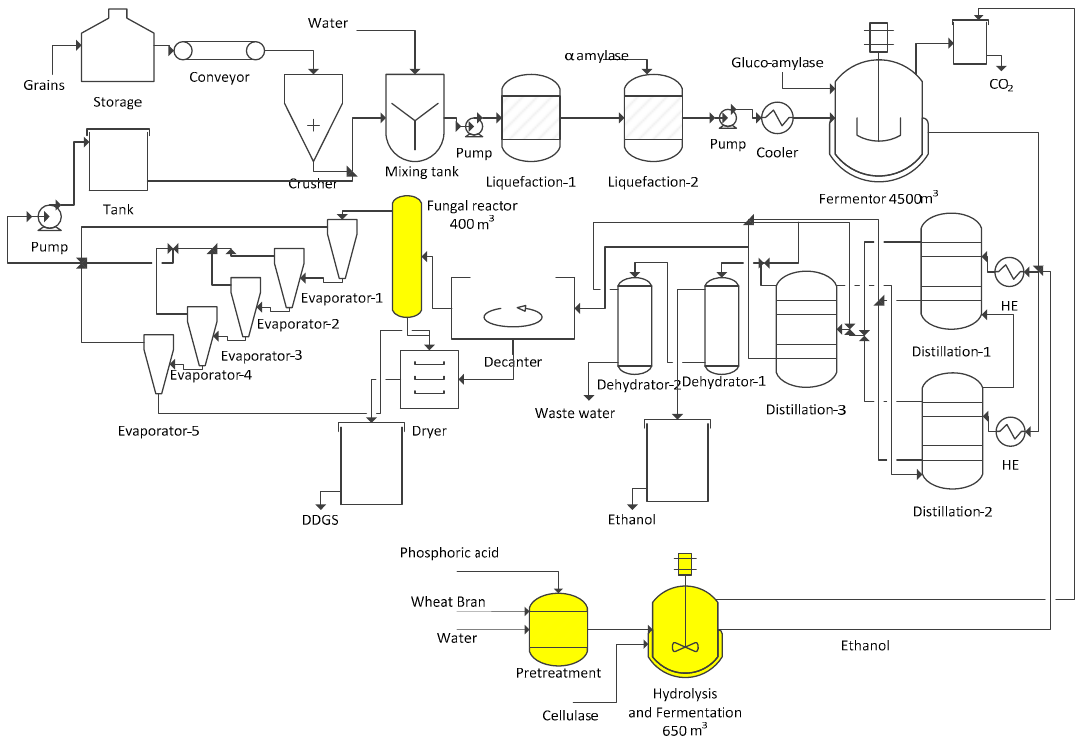
Table 1. Wheat bran composition used for the simulation.